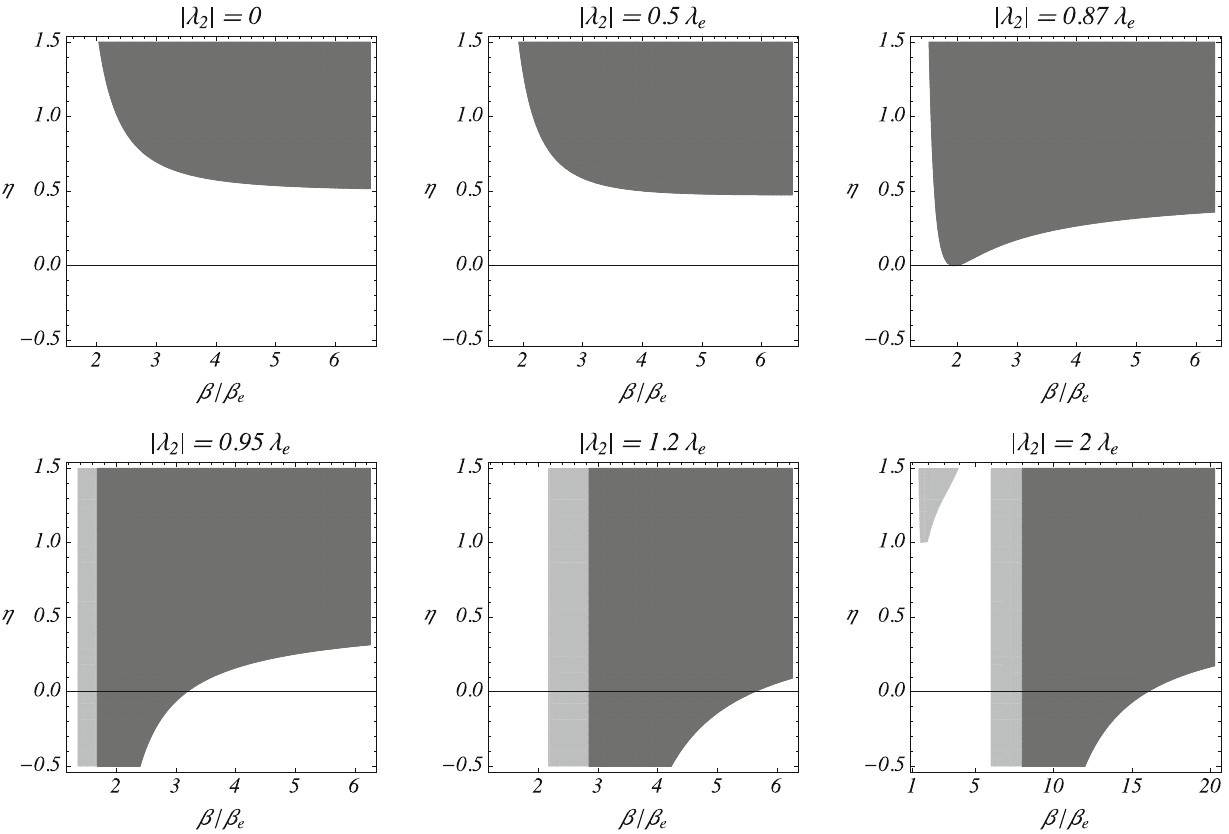
Fig. 3 Idem Fig. 2, now with m 1 = 0 . 5 m 2 . In this case, the critical value where the transition occurs is λ c = 2 2 / 3 3 − 1 / 2 λ e ≈ 0 . 92 λ